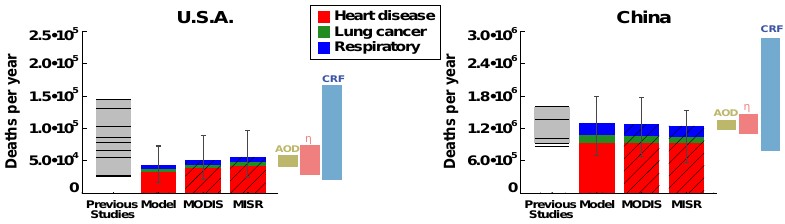
Figure 10. Burden of mortality due to outdoor exposure to fine particulate matter as determined in previous studies (Table 1, gray bars with values from individual studies designated by black lines), calculated using model (GEOS-Chem, solid) and satellite-based (hatched) annual concentrations (colored by disease, whiskers denote 5th and 95th percentile estimates generated using the Burnett et al., 2014, coefficients). The uncertainty range on the MODIS-based estimates due to satellite AOD (taupe), model η (coral), and CRF (blue) are shown on the